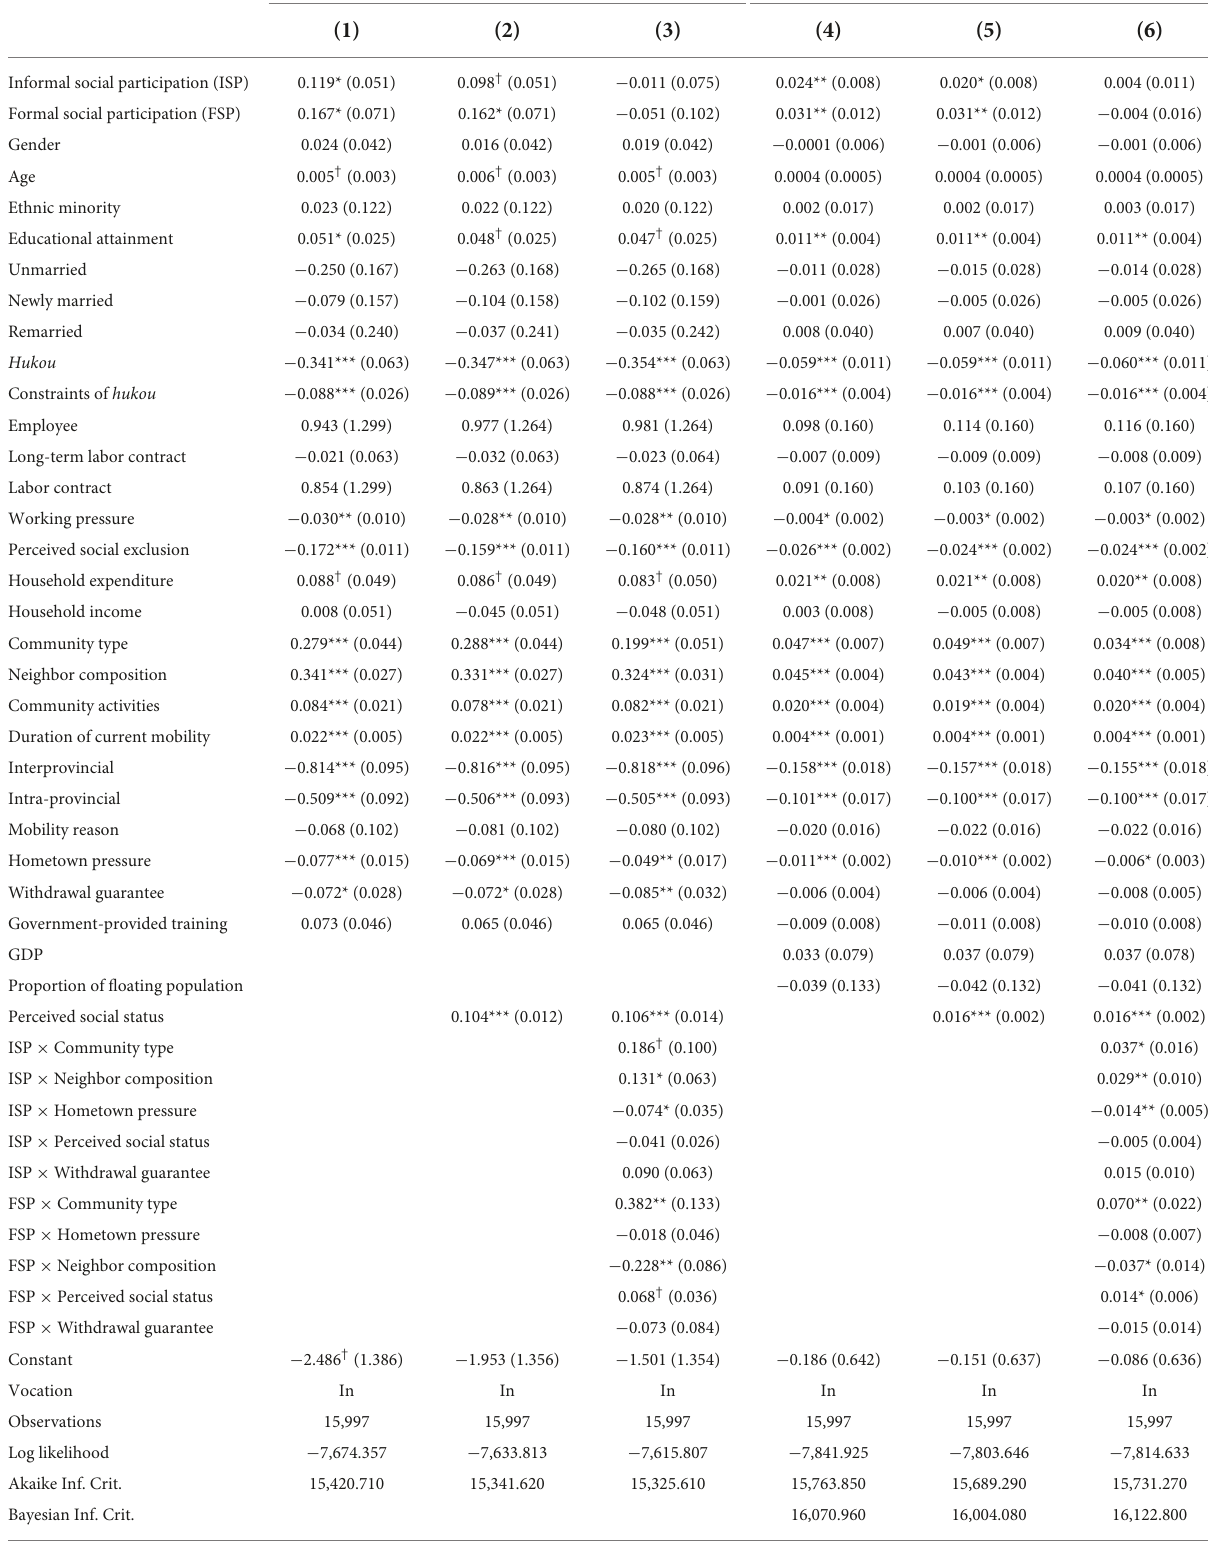
TABLE 2 Predictors of migrants’ local identity by logistic models and GHLM. Logistic Generalized hierarchical linear